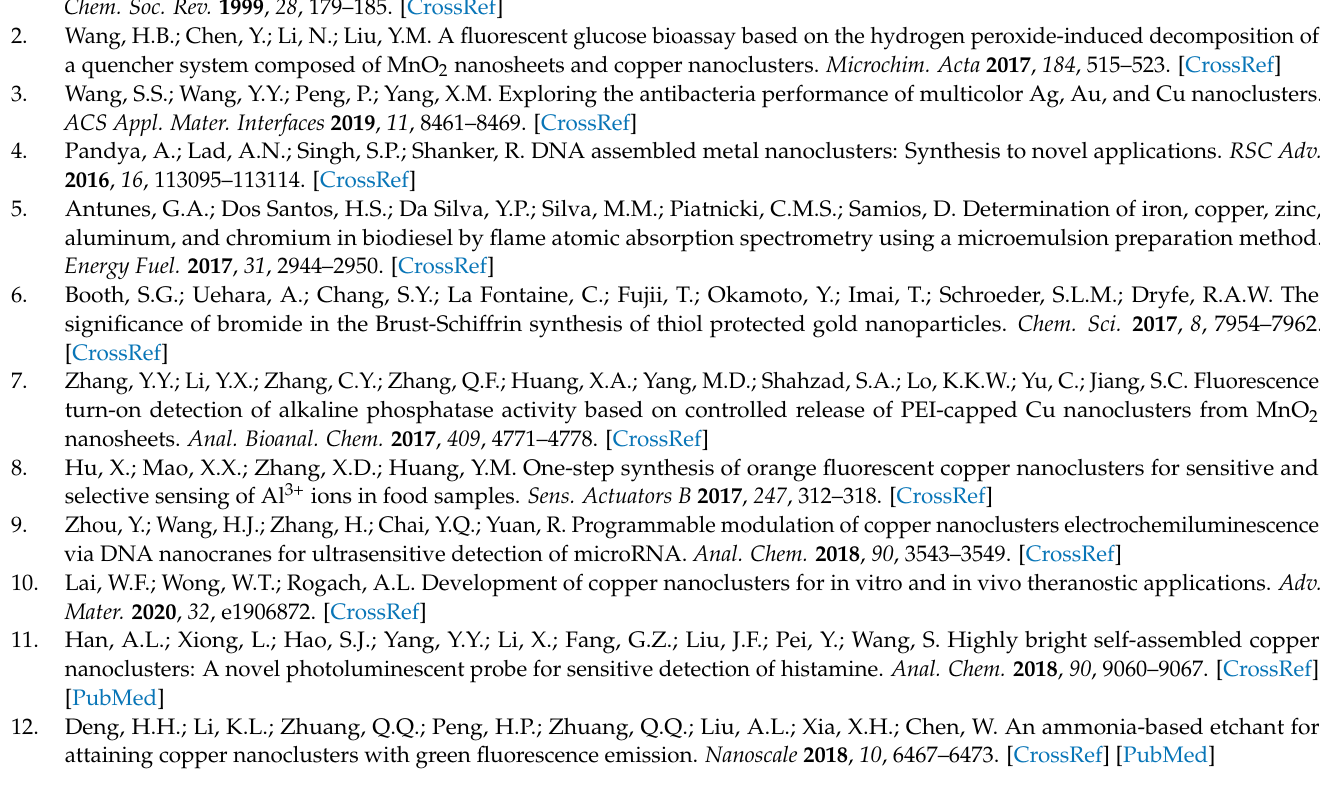
wavelengths, Figure S2A–G: Optimization experiments; Table S1: Comparison of characteristics of some OTC analysis methods reported, Table S2: Influence of interfering ions on RRS determination of OTC, Table S3: Influence of interfering ions on SERS determination of